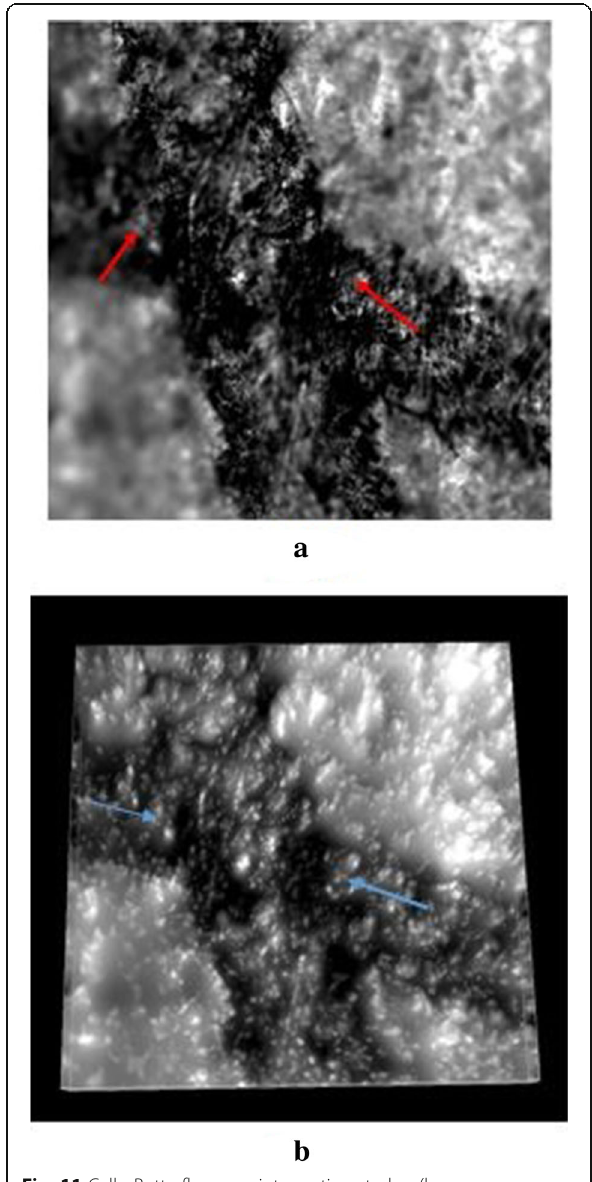
Fig. 11 Cello Butterflow pen intersecting strokes (heavy pen pressure) a 2D figure. b 3D